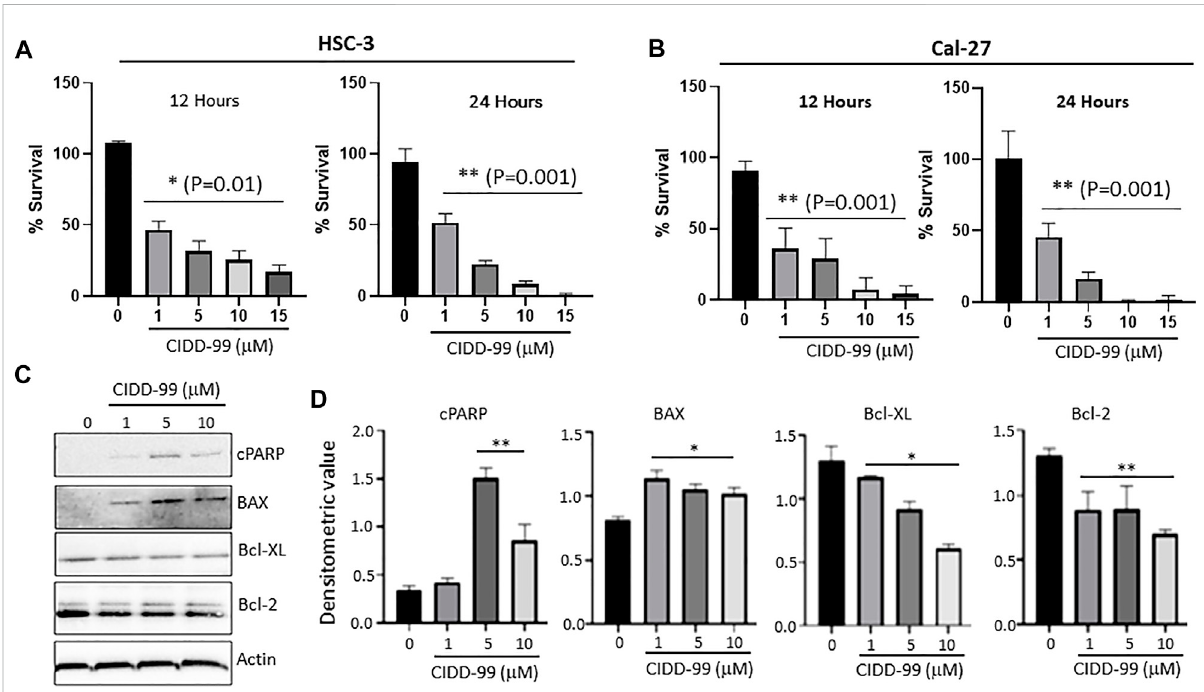
FIGURE 1 Cal-27 and HSC-3 cells show dose-dependent reduced proliferation when treated with CIDD-99. Cal-27 and HSC-3 OSCC cell lines were treated with various concentrations of CIDD-99 over varying time courses and percent survival was measured by MTT cell viability assay. (A) HSC-3 cells treated for 12 and 24 h. (B) Cal-27 cells treated for 12 and 24 h respectively. n = 3, with 3 independent replicates. Signi fi cance was determined using one-way ANOVA and * indicates p = 0.01, whereas ** indicates p = 0.001 respectively. (C) Cal-27 cells were treated with CIDD-99 at concentrationsof0,1,5and10 µMforaperiodof24 h.After24 h,cellswerelysedandanalyzedforapoptoticmarkersbywesternblot.Westernblots were quanti fi ed using ImageJ. (D) Western blot antibody ratio for cPARP, BAX, Bcl-XL, and Bcl-2 compared to actin loading control. n = 3 with 2 independent replicates and signi fi cance was determined using T-test and * indicates p = 0.01, whereas ** indicates p = 0.001